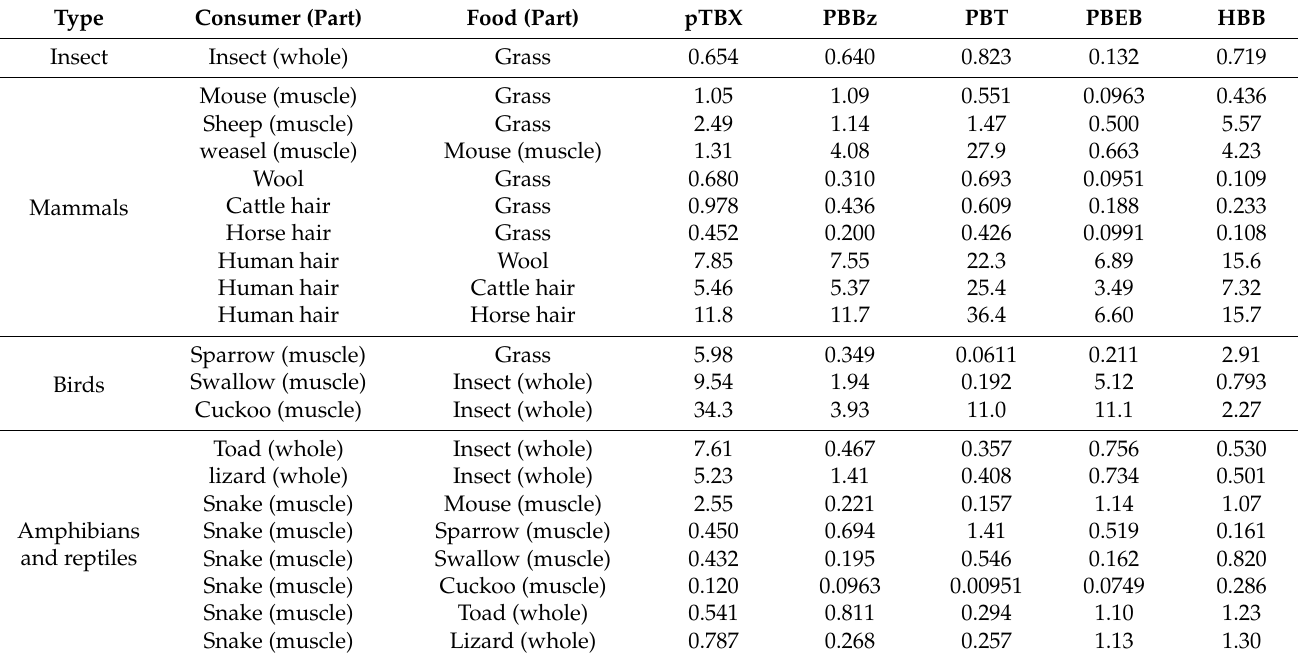
Table 1. Novel brominated flame retardant biomagnification factors for the samples from grassland in Inner